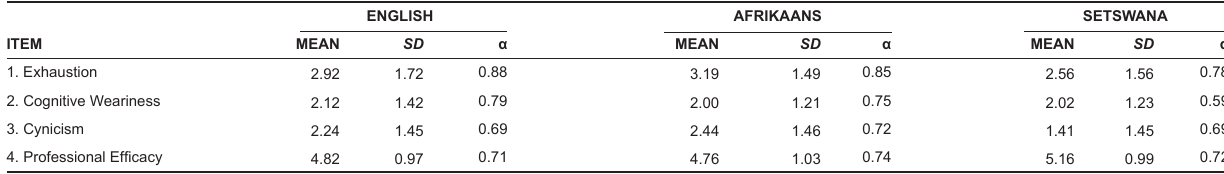
TABLE 5 Descriptive statistics and alpha coefficients of the adapted and translated MBI-GS